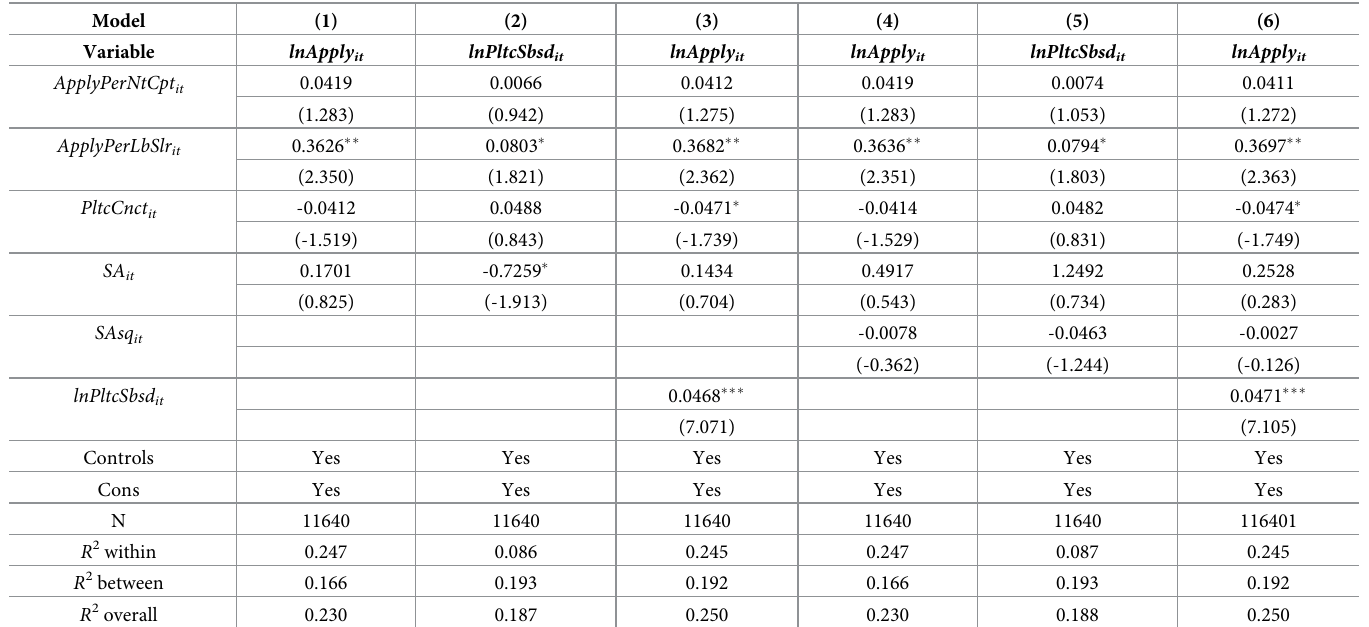
Table 9. Main results of random